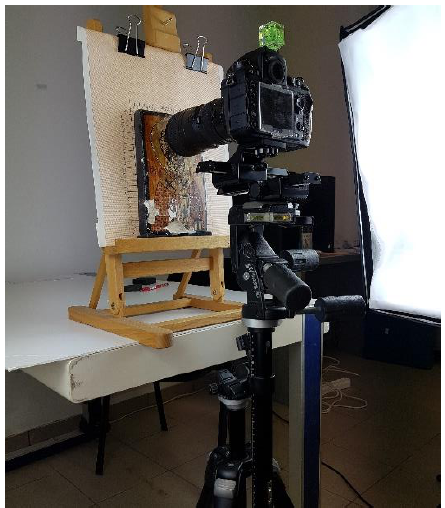
Figure 4. Setup for macro shooting. Vertical graded slider and horizontal X-Y graded